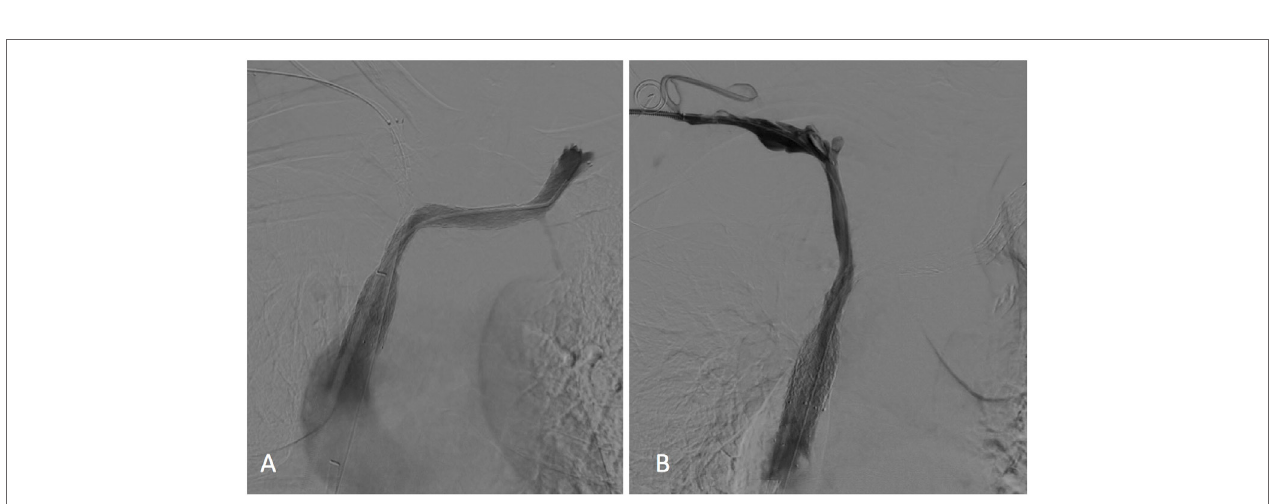
FIgURe 3 | Left (a) and right (B) subclavian venograms obtained after stents placement showed restoration of superior vena cava and both brachiocephalic veins patency without collateral channels. No significant residual stenosis was observed within the